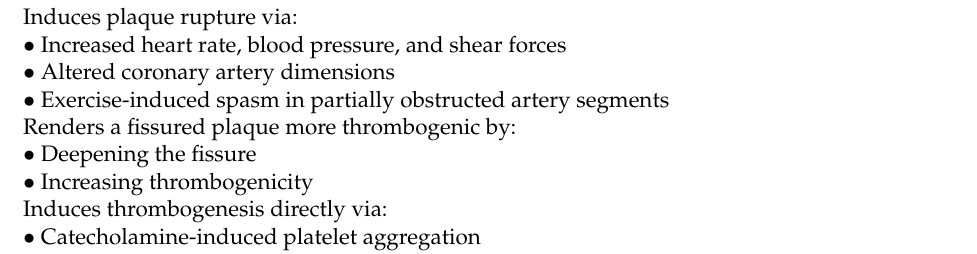
Table 1. Potential triggering mechanisms of acute myocardial infarction by strenuous physical